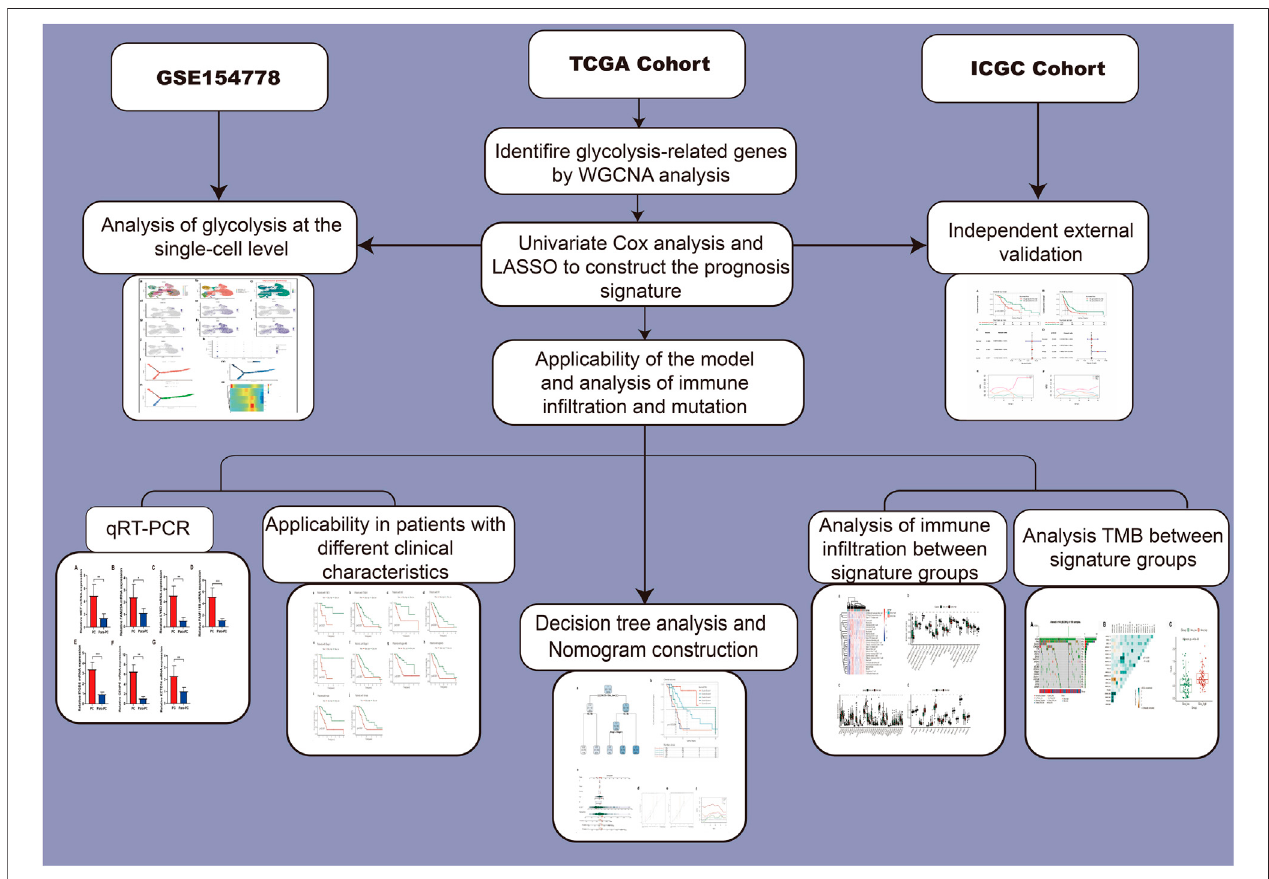
FIGURE 1 | Flow chart of our